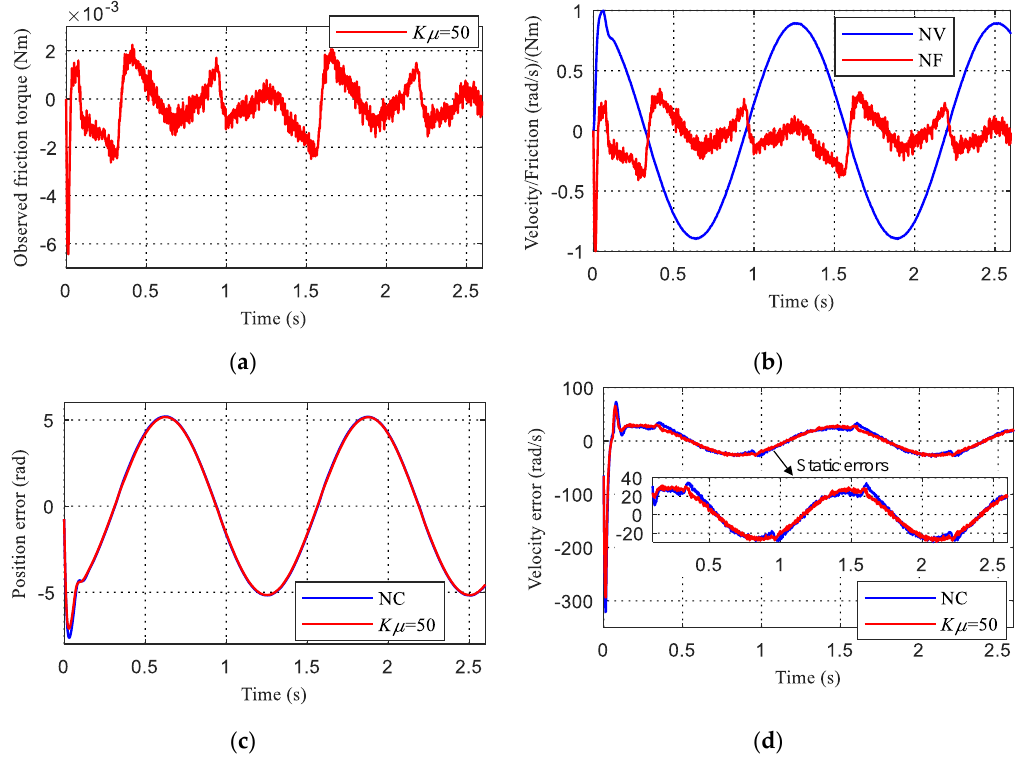
Figure 12. Motor high-velocity without payload experiment results. ( a ) Observed total friction torque mapped to the motor side at high velocities. ( b ) Normalized actual motor velocity (NV) and normalized friction torque (NF). ( c ) Motor position tracking errors at high velocities. ( d ) Motor velocity tracking errors at high velocities.